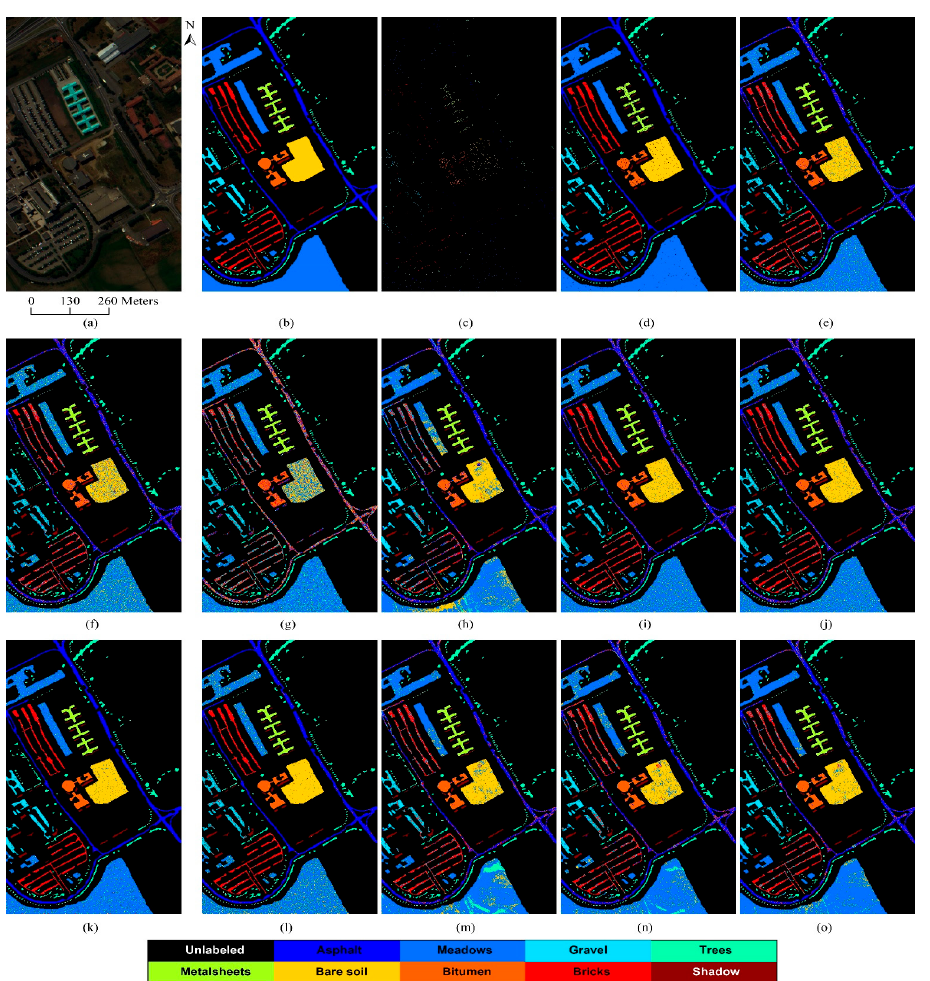
Figure 6. Classification maps generated with 120 training samples per class on the University of Pavia image. ( a ) Pseudocolor image (bands 46, 27 and 10); ( b ) ground truth; ( c ) training